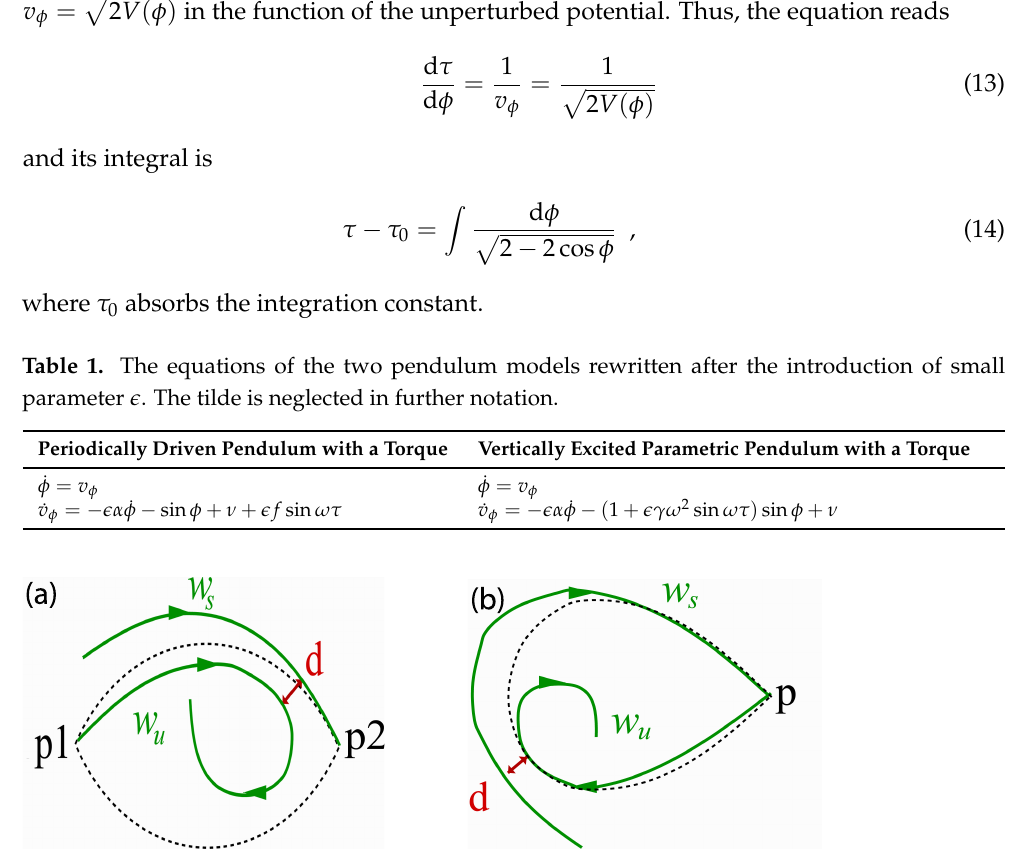
Figure 7. Schematic plots of the stable W s and unstable W u manifolds as perturbed heteroclinic (for ν = 0, Figure 4, red curve ( a )) and homoclinic orbits (for ν > 0 Figure 4, blue curve ( b )). The points in phase space p 1, p 2, and p denote the corresponding saddle fixed points. Dashed lines correspond to unperturbed cases. d defines the shortest distances the stable and unstable manifolds. d = 0 implies their cross-section and mixing of